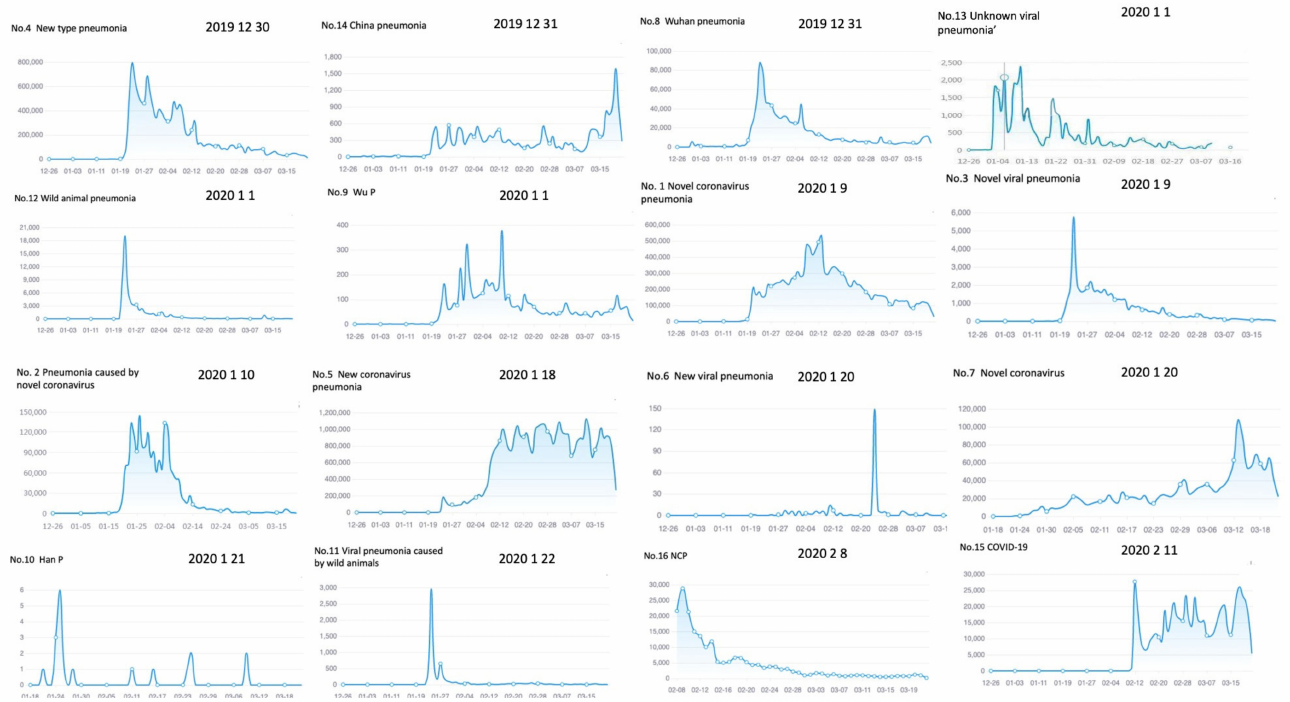
Figure 2. Timelines of 16 coronavirus-related infectious disease